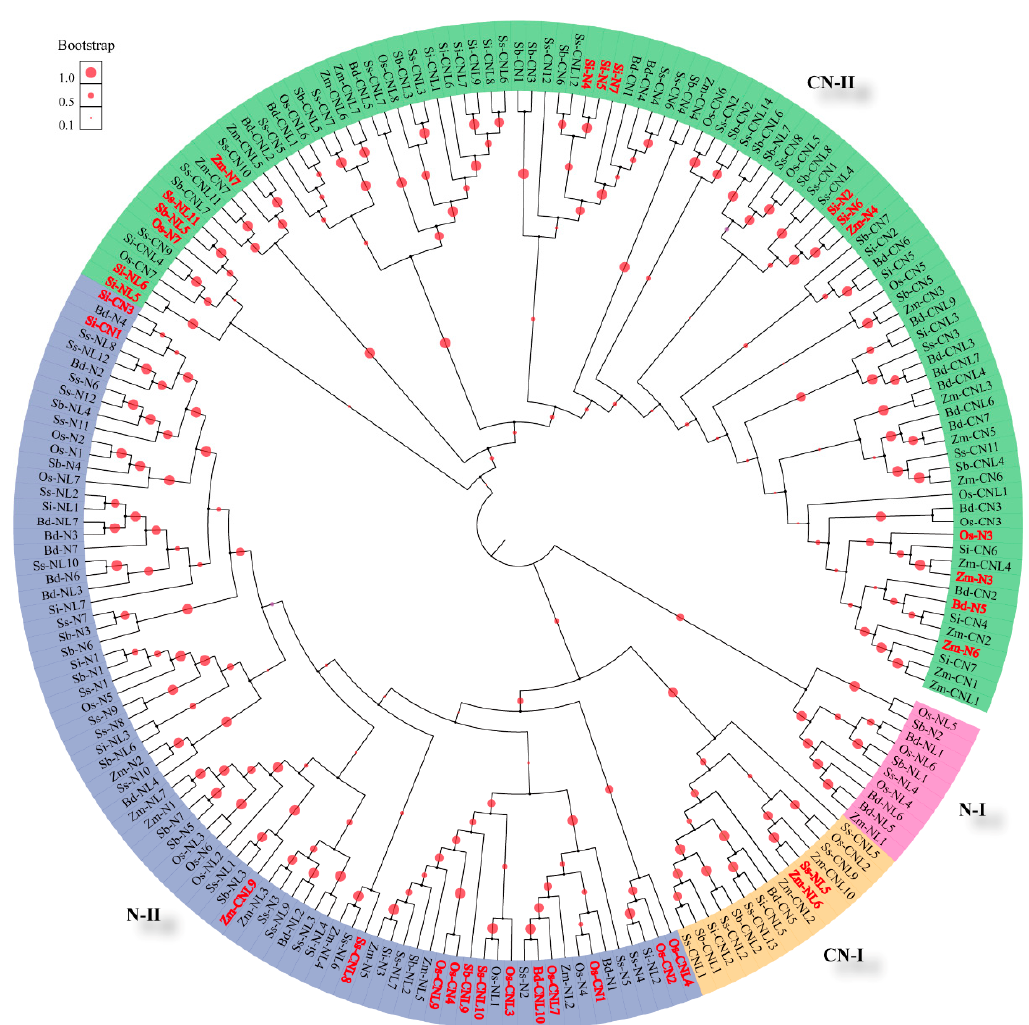
Figure 2. Comparative phylogenetic analysis of NLR genes among six Poaceae plants. A total of 200 NLR proteins randomly selected from Saccharum spontaneum , Setaria italica , Oryza sativa , Brachypodium distachyon , Sorghum bicolor, and Zea mays were constructed into a phylogenetic analysis. For clarity, each protein is encoded as follows: acronym for species name + protein name (protein type N, NL, CN, and CNL + number). Fifty NLR proteins belong to S. spontaneum (12 CNs + 12 NLs + 12 Ns + 14 CNLs), and 150 NLR proteins (7 CNs + 7 NL7s + 7 Ns + 9 CNLs) on average were selected from each of the five other species. Bootstrap values (set at 1000 replications) are indicated in every branch with a red circle size.